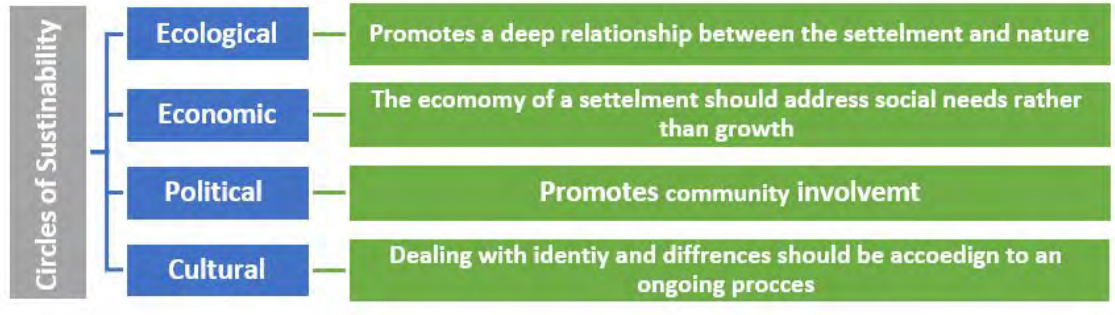
Figure 1. principles of circles ofsustainability adopted by (James et al.,